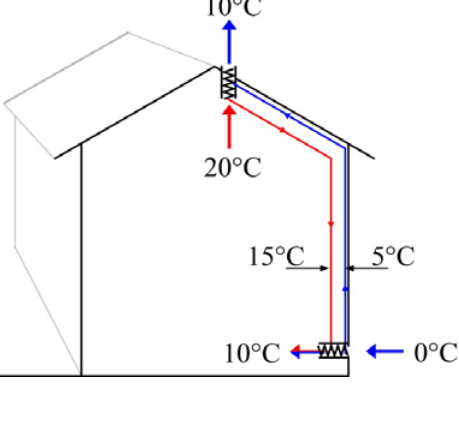
Figure 1. The principle of the proposed hybrid ventilation system with heat